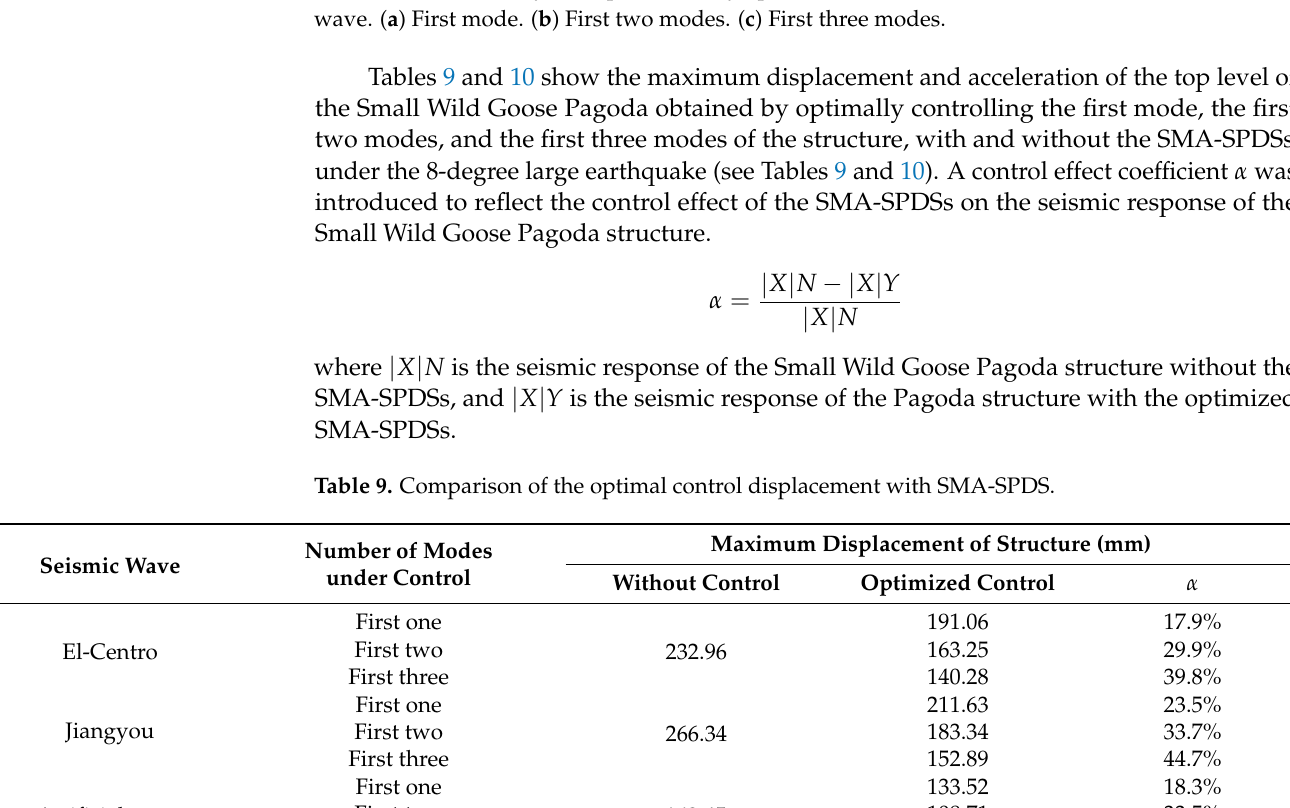
Figure 22. Time history of displacement by optimized control at different modes under the artificial wave. ( a ) First mode. ( b ) First two modes. ( c ) First three modes. Tables 9 and 10 show the maximum displacement and acceleration of the top level of the Small Wild Goose Pagoda obtained by optimally controlling the first mode, the first two modes, and the first three modes of the structure, with and without the SMA-SPDSs, under the 8-degree large earthquake (see Tables 9 and 10). A control effect coefficient α was introduced to reflect the control effect of the SMA-SPDSs on the seismic response of the Small Wild Goose Pagoda structure.